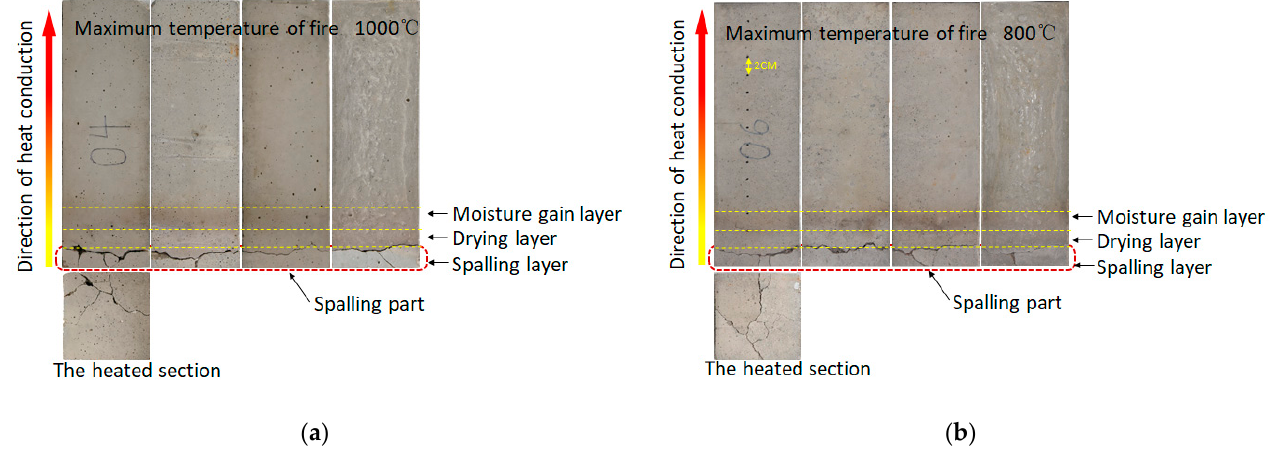
Figure 6. Images of the side surface of concrete sample under different fire temperatures: ( a ) maximum temperature of 1000 °C; ( b ) maximum temperature of 800 °C.